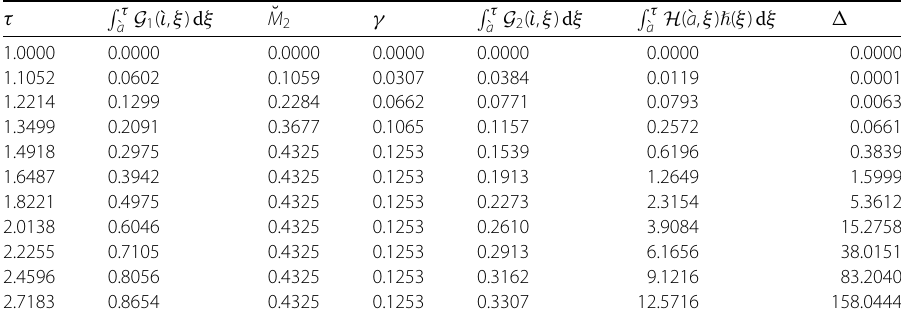
Table 3 Numerical values of